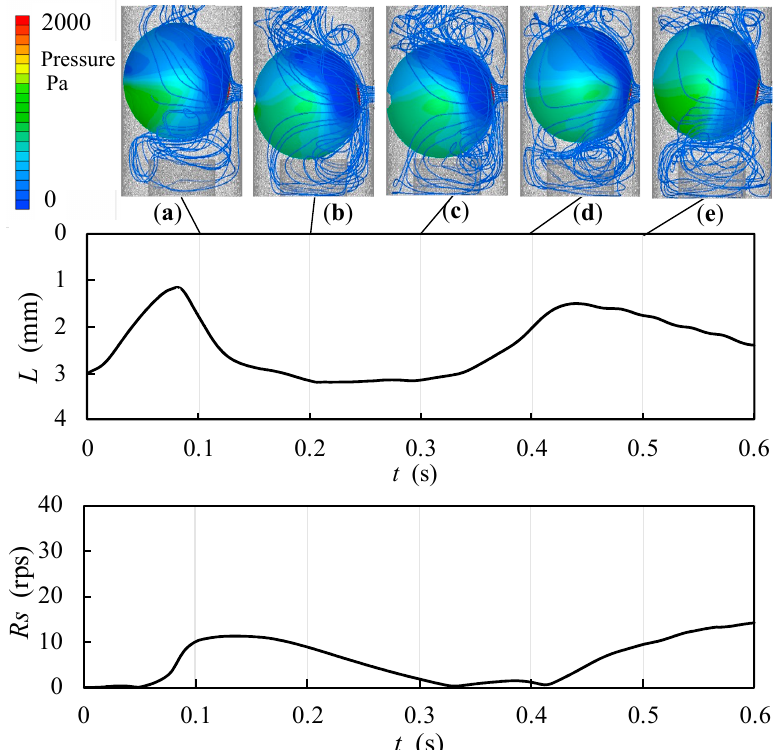
Figure 7. Time variation of lift and rotation speed in low-viscosity case of Model (b): Streamlines and ball surface pressure distribution ( a ) 0.1 s, ( b ) 0.2 s, ( c ) 0.3 s, ( d ) 0.4 s ( e ) 0.5 s.